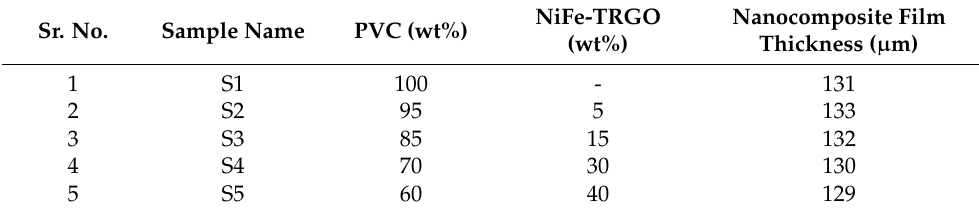
Table 1. The composition of nanocomposites film of PVC/NiFe-TRGO. Sr.